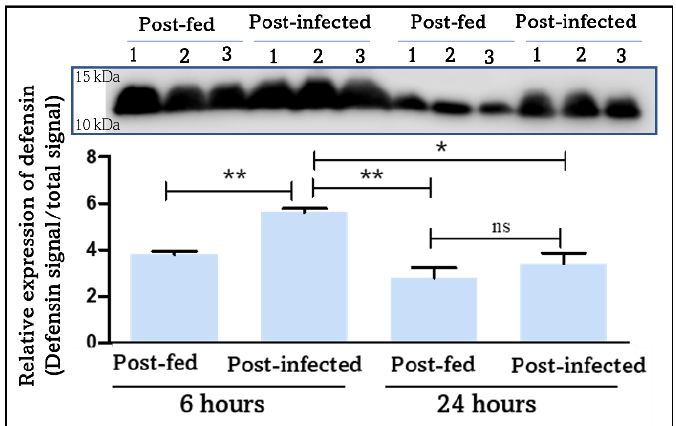
Figure 5. Western blot validation of defensins’ temporal expression profile in the hemolymph at 6 h and 24 h post-blood feeding and T. cruzi infection. The relative expression of defensins was calculated by normalizing the band intensity of defensins to the intensity of the total proteins signal. The results are expressed as the mean ± SEM ( n = 3). Statistical significance is shown by * (* p ≤ 0.05 and ** p ≤ 0.01), calculated by unpaired t -test.